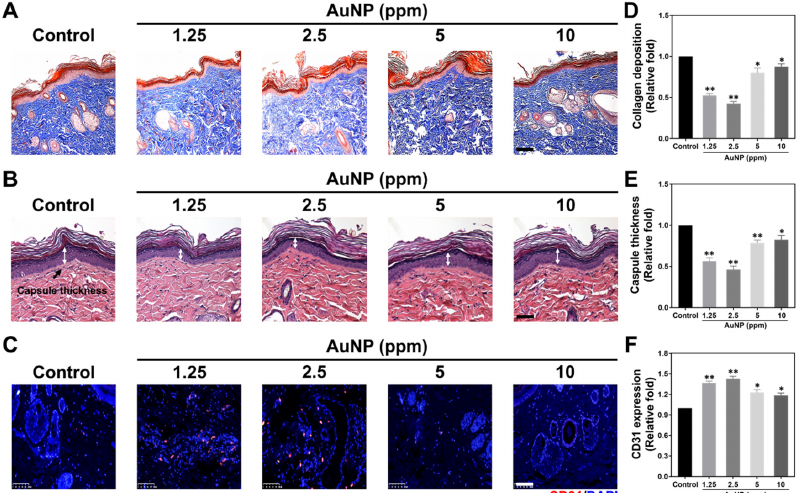
Figure 10. Biocompatibility investigations in the rat model with four weeks of AuNP treatments. ( A ) The collagen deposition (blue color) was measured via Masson’s trichrome staining assay. ( B ) The capsule formation (white double arrow) was explored through H&E staining assay. ( C ) The expression of the CD31 endothelial marker was observed after immunohistochemical (IHC) staining assay. The cell nuclei were located with DAPI solution (blue fluorescence), while the red fluorescence was presented as a CD31 marker expression. The scale bars of images were equal to 100 µ m. ( D ) The semi-quantitative results of collagen deposition were influenced by AuNP treatments. ( E ) The capsule thickness of tissues in each treatment was semi-quantified. ( F ) The CD31 expression intensity was also quantified. The above evidence indicates that AuNPs at the concentrations of 1.25 and 2.5 ppm could induce the lowest foreign body response, and significantly enhanced the endothelialization for tissue regeneration. The data are demonstrated as mean ± SD ( n = 3). * p < 0.05, ** p < 0.01: compared to the Control group (TCPS).